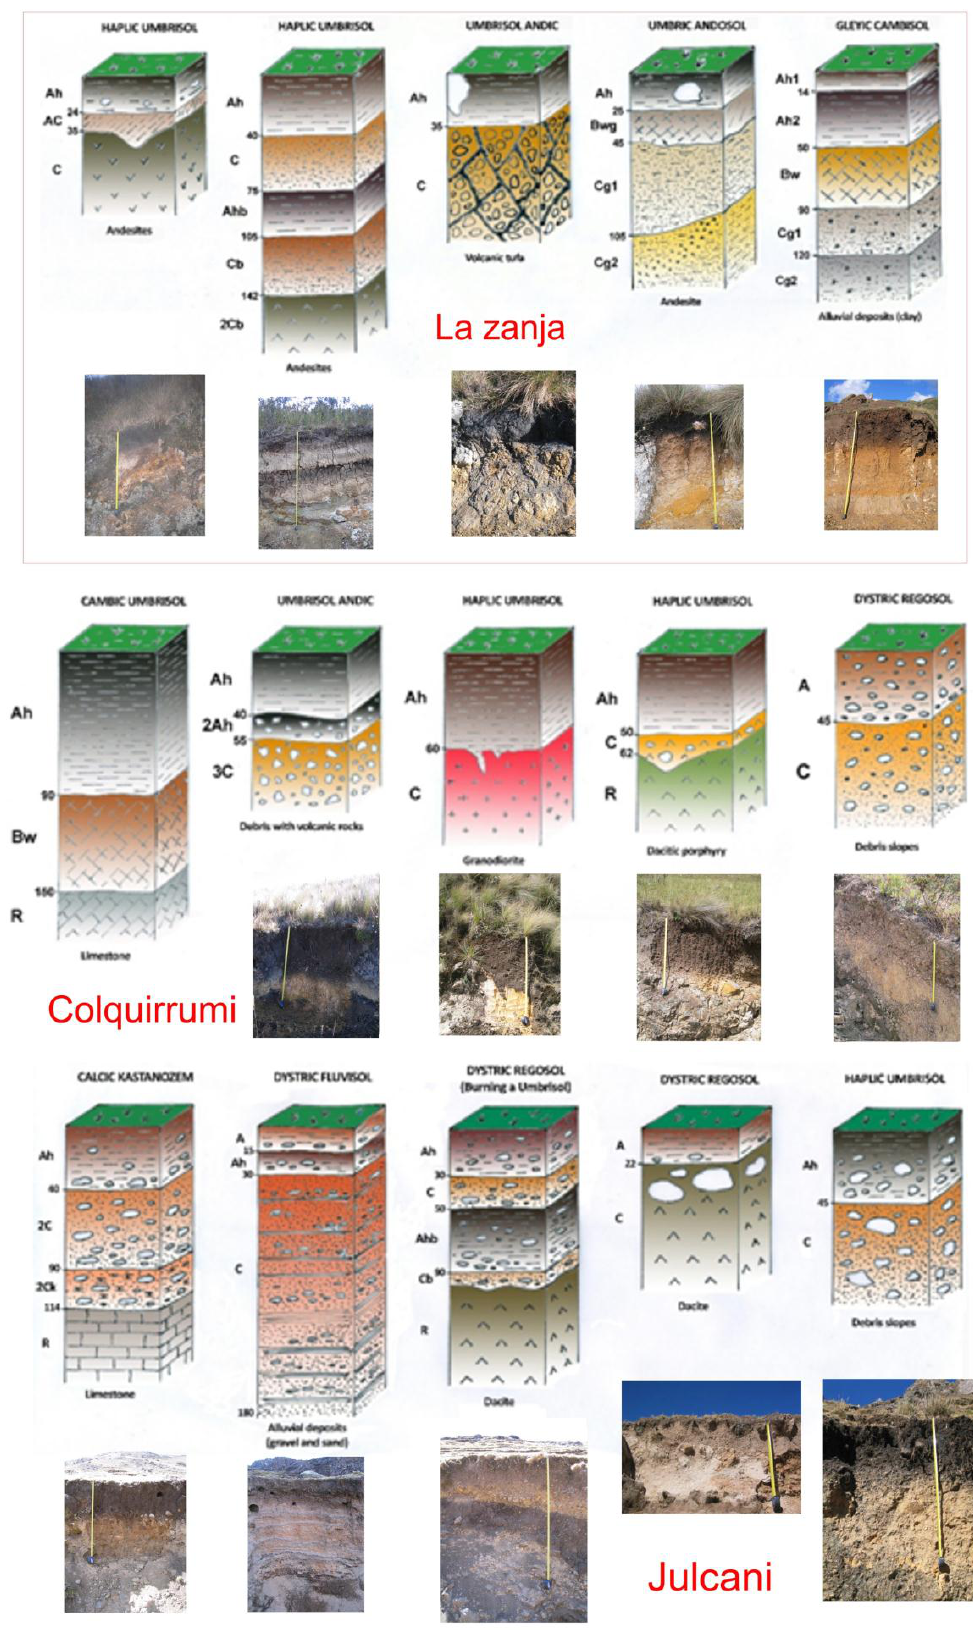
Figure 3. Morphology of the soils most representative of the studied